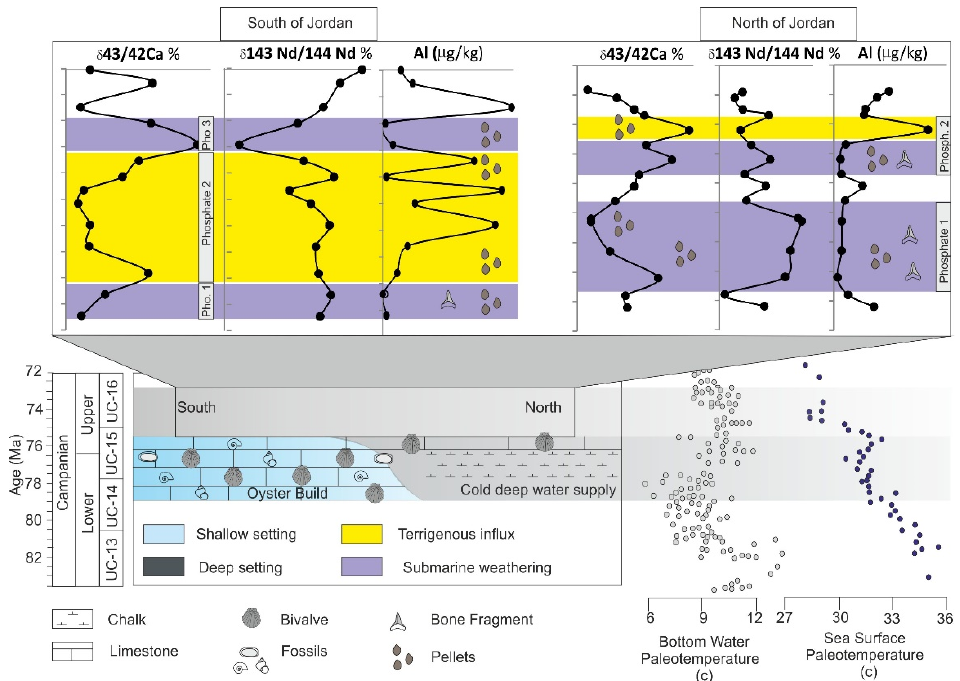
Figure 10. Integration of the geochemical, biostratigraphical, and petrographical interpretations shows the variation in oceanic circulation and continental weathering. Bottom and surface paleotemperature are taken from Linnert et al., 2014.